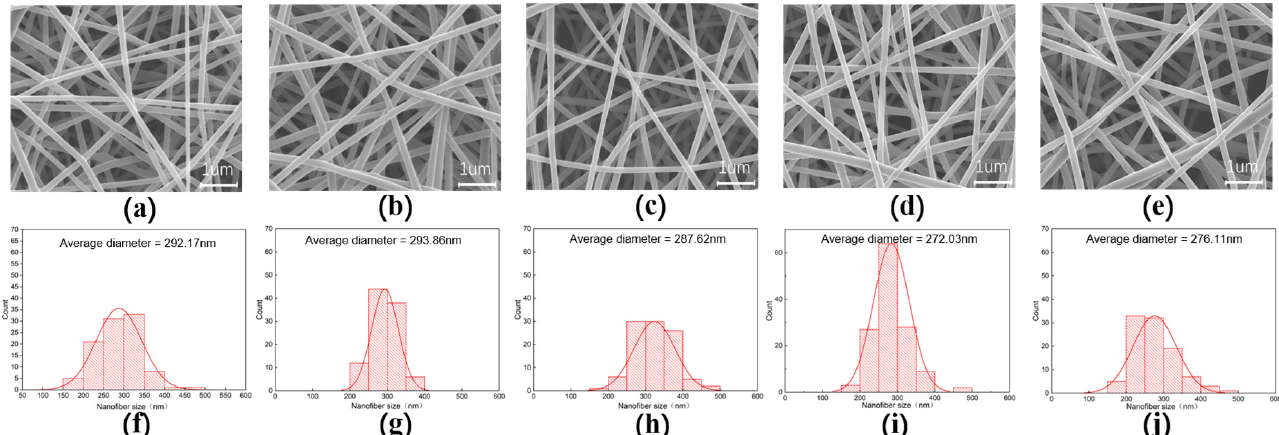
Figure 6. The SEM images and fiber diameter distribution diagrams of PVA/NC nanofiber membranes with different NC content. ( a , f ) are the electron microscope image and diameter distribution diagram of NC0, respectively. ( b , g ) are the electron microscope image and diameter distribution diagram of NC2, respectively. ( c , h ) are the electron microscope image and diameter distribution diagram of NC4, respectively. ( d , i ) are the electron microscope image and diameter distribution diagram of NC6, respectively. ( e , j ) are the electron microscope image and diameter distribution diagram of NC8, respectively.